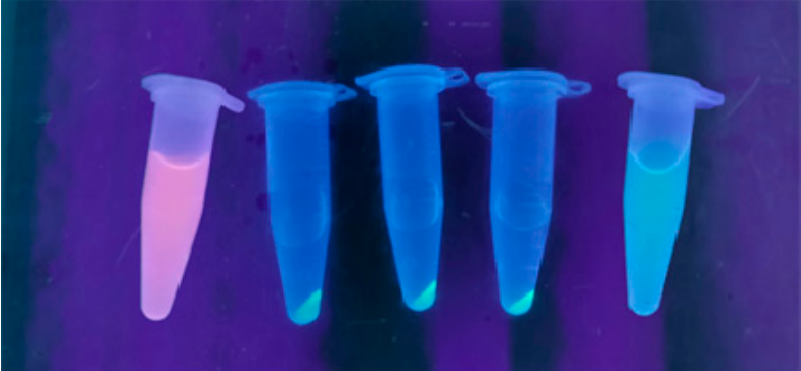
Figure 5. Assessment of preferential binding of his-tagged proteins to Ni 2+ and Co 2+ alginate hydrogels. Samples incubated with different fluorescent proteins were centrifuged and UV illuminated. From right to left: Ni 2+ alginate + TurboRFP; Ni 2+ alginate + EGFP-HisTAG; Co 2+ alginate + EGFP-HisTAG; Ni 2+ alginate + EGFP-HisTAG; Ni 2+ alginate + EGFP.